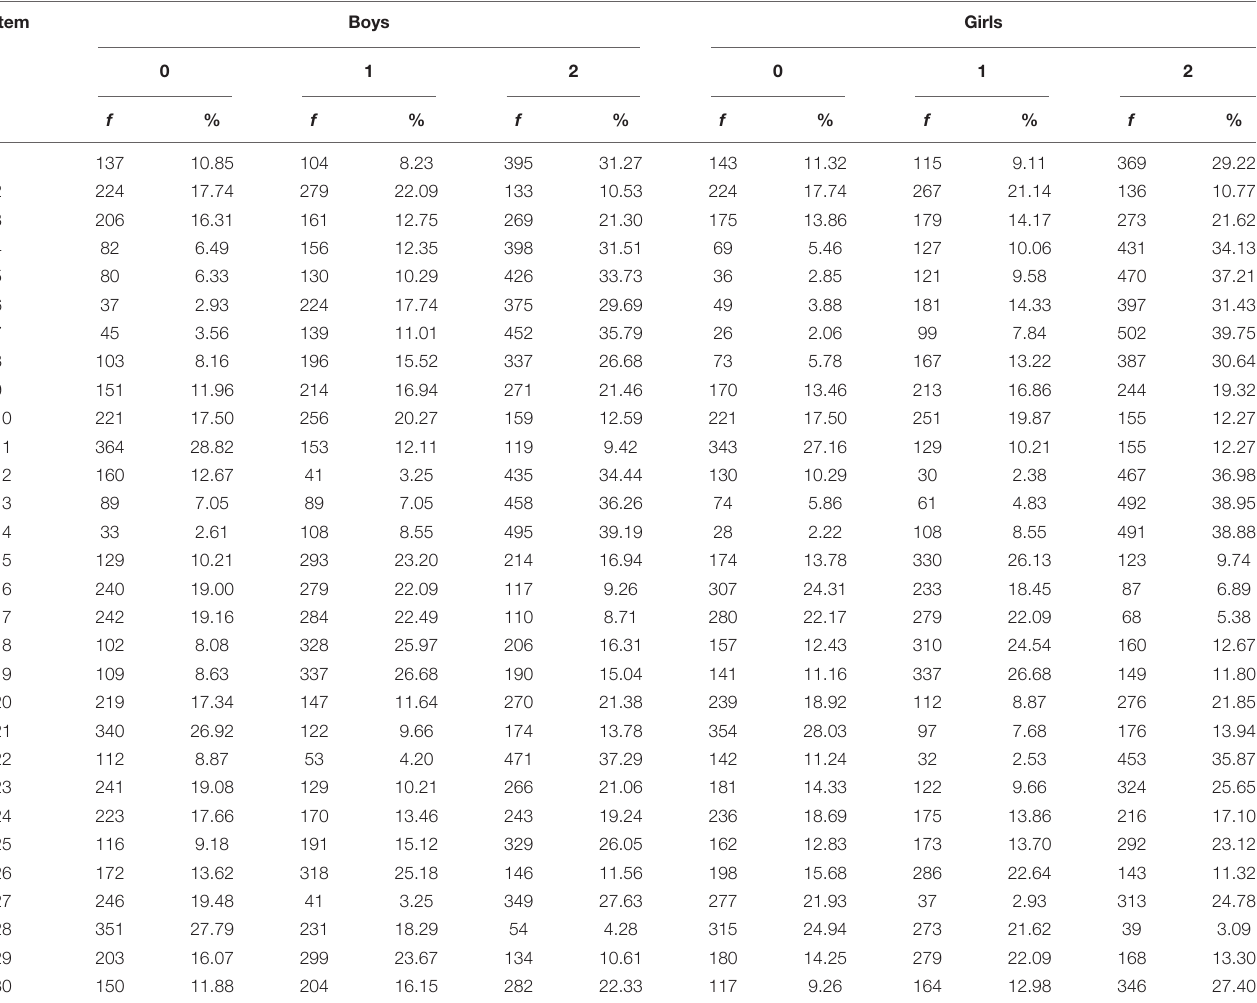
TABLE 8 | Frequencies and percentages by sex from students with level 2